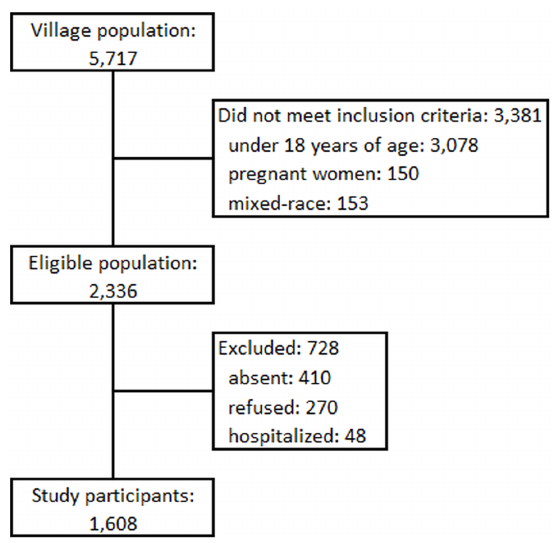
Figure 1. The process of inclusion of participants in the study.